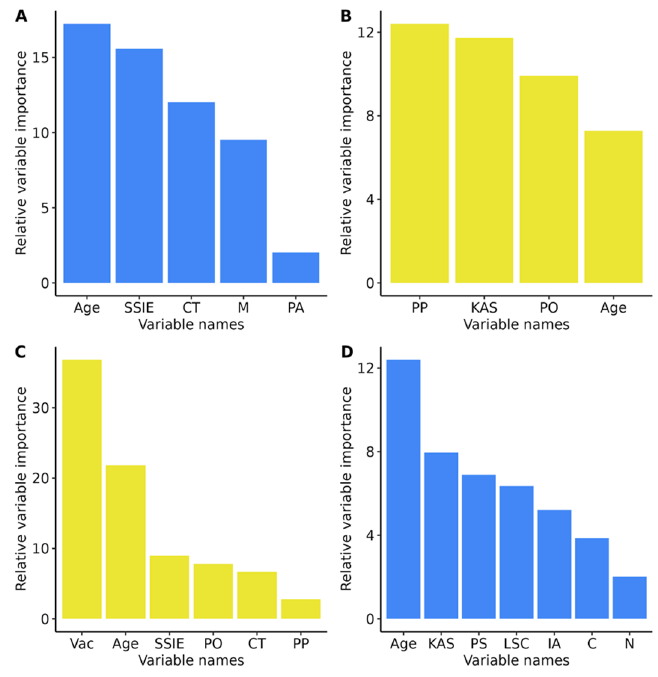
Figure 5. Variable importance for all predictive models: ( A )—shopping gallery, ( B )—cultural facility, ( C )—public transportation, and ( D )—work. Abbreviations: PP—preference for predictability, LSC—lack of self-confidence, Vac—vaccination status, N—narcissism, D—determination, IA—intolerance of ambiguity, PS—Psychopathy, PA—passivity, C—compliance, CT—closed-mindedness, M—Machiavellianism and PO—preference for order.